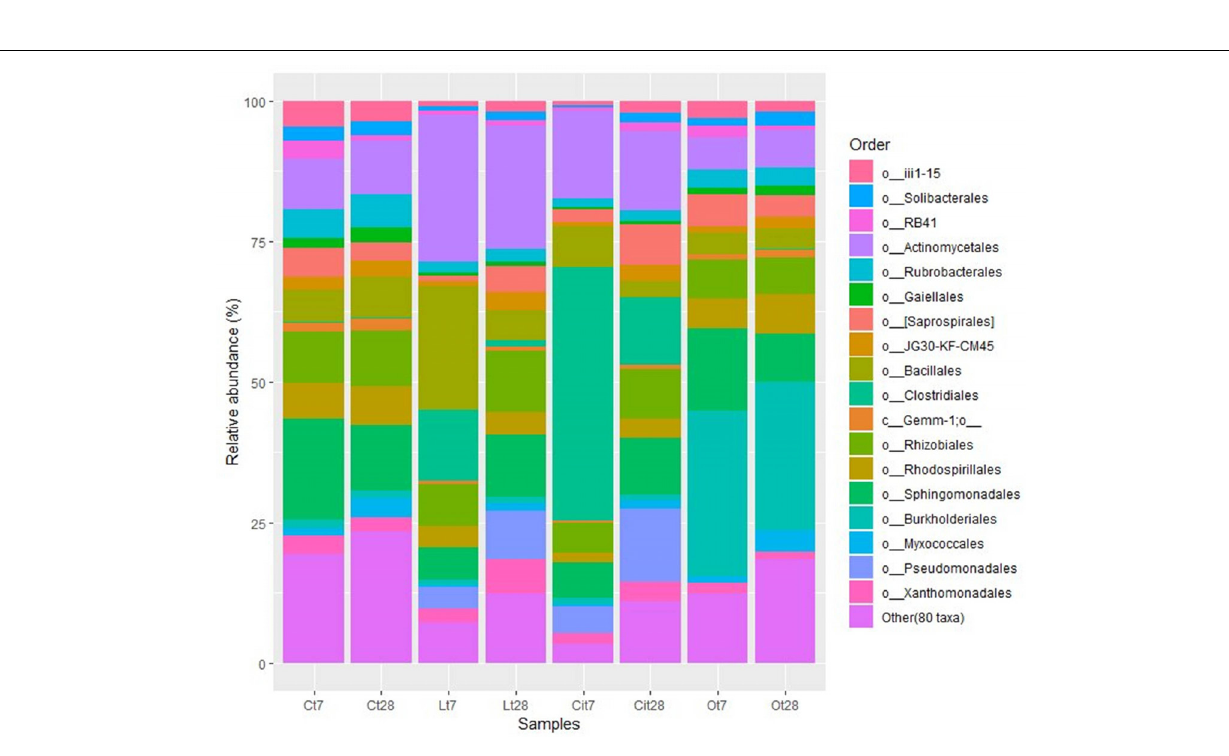
Frontiers in Plant Science |